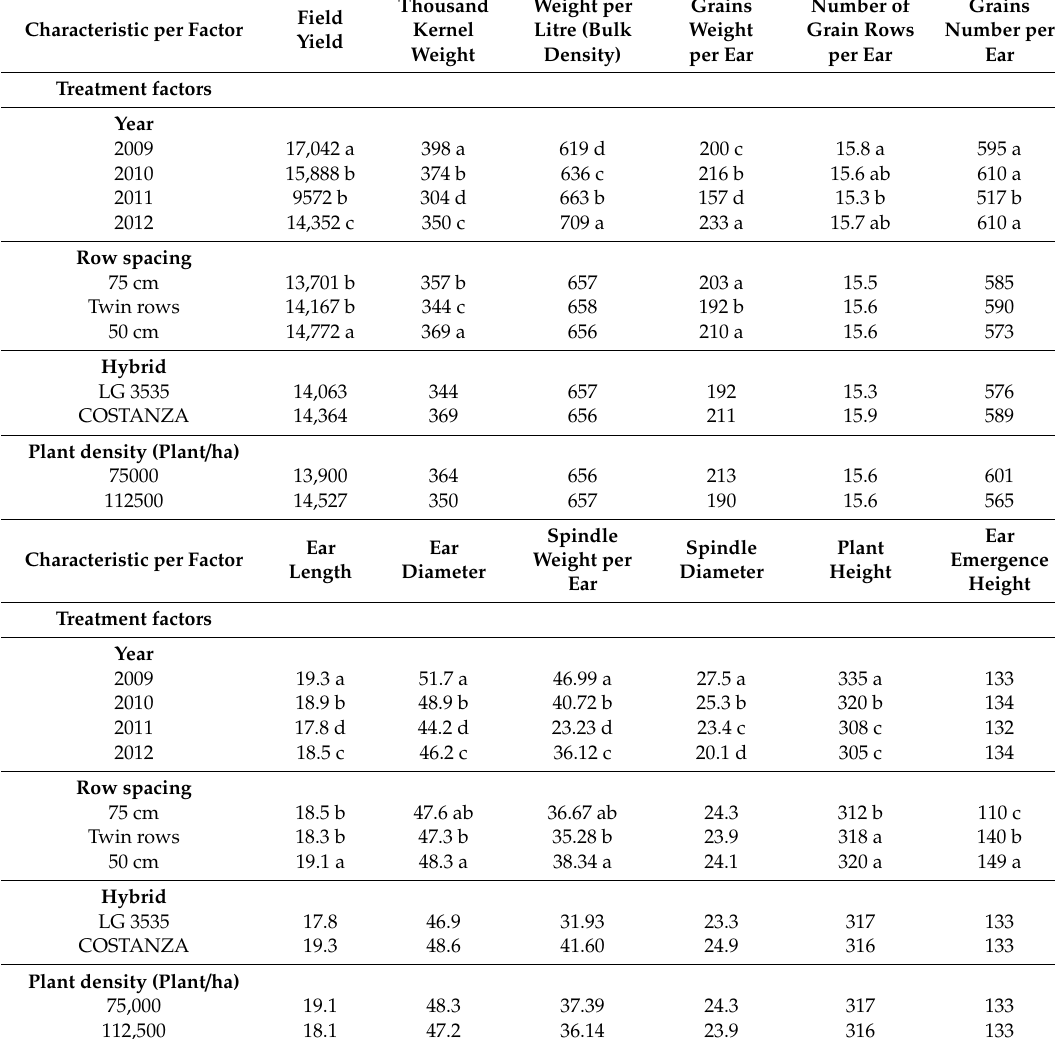
Table 1. Means of each characteristic per factor for: Field yield in kg / ha, thousand kernel weight (in g), weight per liter-bulk density (in g / L), grains weight per ear, number of grain rows per ear, grains number per ear, ear length (in mm), ear diameter (in mm), spindle weight per ear (in g), spindle diameter (in mm), plant height (in cm), ear emergence height (in cm), across all factors (year, row spacing, hybrid and plant